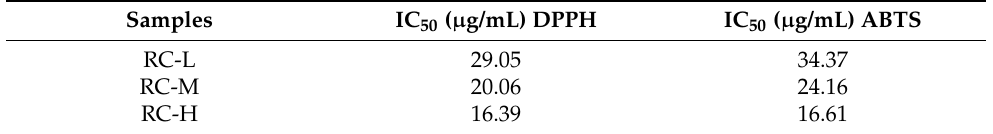
Figure 4 . Contents of ascorbic acid in rhizomes of Rhodiola crenulata (RC-L, RC-M, and RC-H) from different altitudes (3933, 4249 and 4531 m), respectively. ( A ): AsA (ascorbic acid); ( B ): AsA/DHA (ascorbic acid/dehydroascorbate); ( C ): Total ascorbic acid. Results are presented as the mean ± SD of six independent experiments ( n = 6). In each column, different letters (a, b) mean significant difference between two groups ( p < 0.05) found via a t -test. Note: Rhodiola crenulata samples are presented according to the ascending order of altitude from left to right.